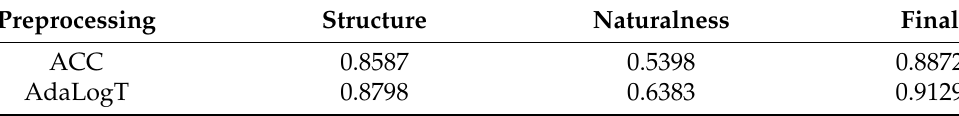
Table 4. Mean TMQI scores of DNN-based TM